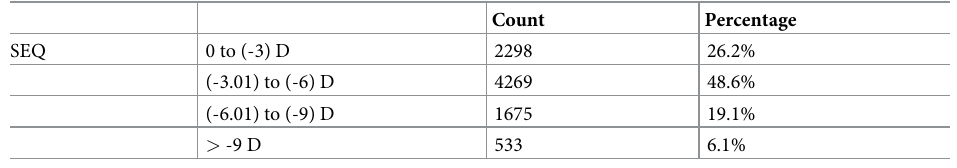
Table 2. SEQ before treatment, categorized.